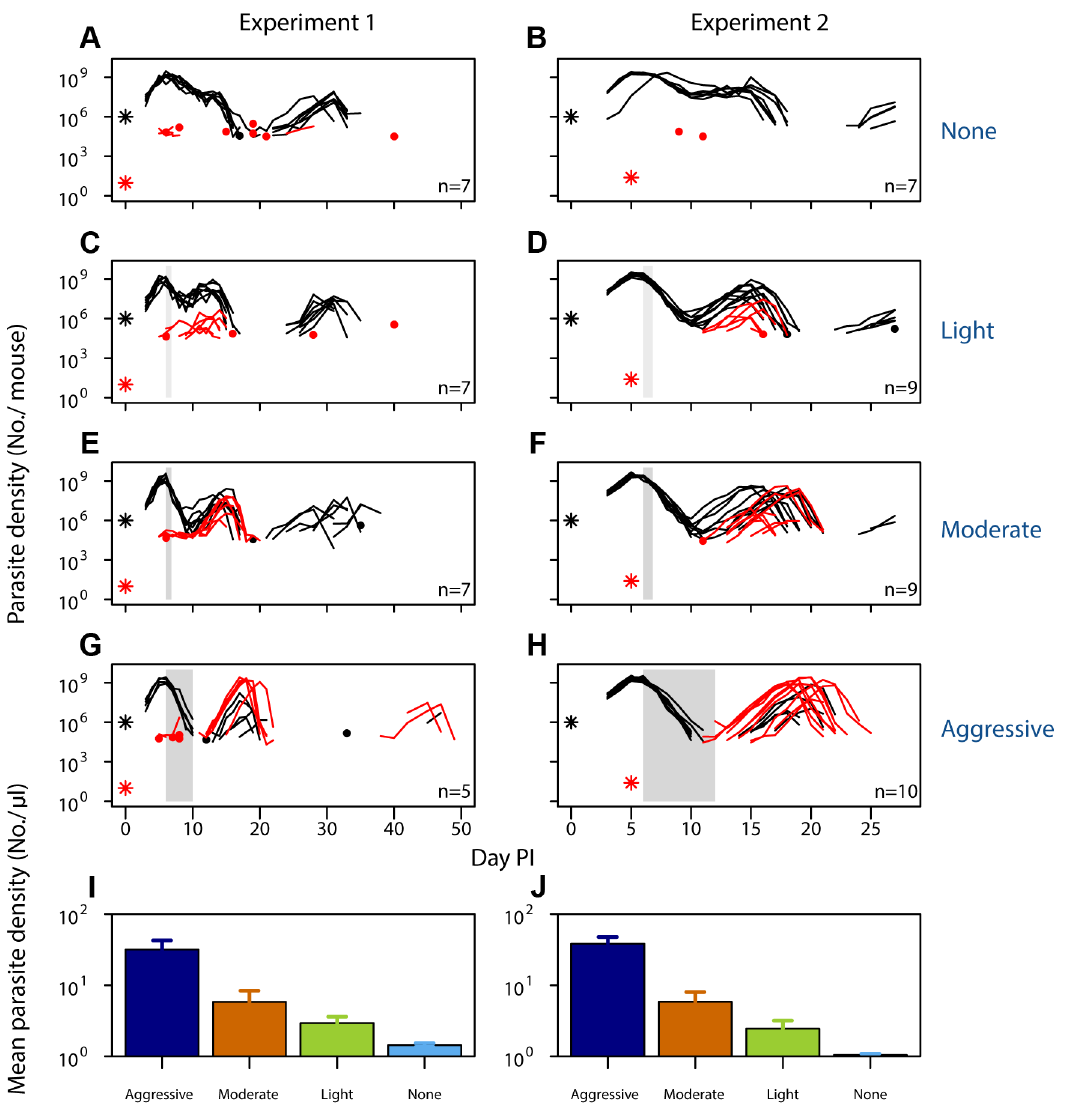
Figure 1. Selection of resistant parasites increases with drug pressure. Parasite dynamics (top four rows) of individual mice in mixed infections of resistant (red lines) and susceptible (black lines) parasites in experiment 1 (left panels) and experiment 2 (right panels) in infections that received no (A,B), light (C,D), moderate (E,F) and aggressive (G,H) treatment. Asterisks indicate the number of parasites at inoculation, dots indicate positive counts detected in individual mice on a single day (parasites not detected the day before and after), grey bars show timing and duration treatment. Bottom row: geometric mean asexual parasite density of resistant parasites during the measured infection period (day 3–49 in experiment 1 [I] and day 3–28 PI in experiment 2 [J]). Data are means ( 6 s.e.m.) with sample sizes (n, number of mice) as in